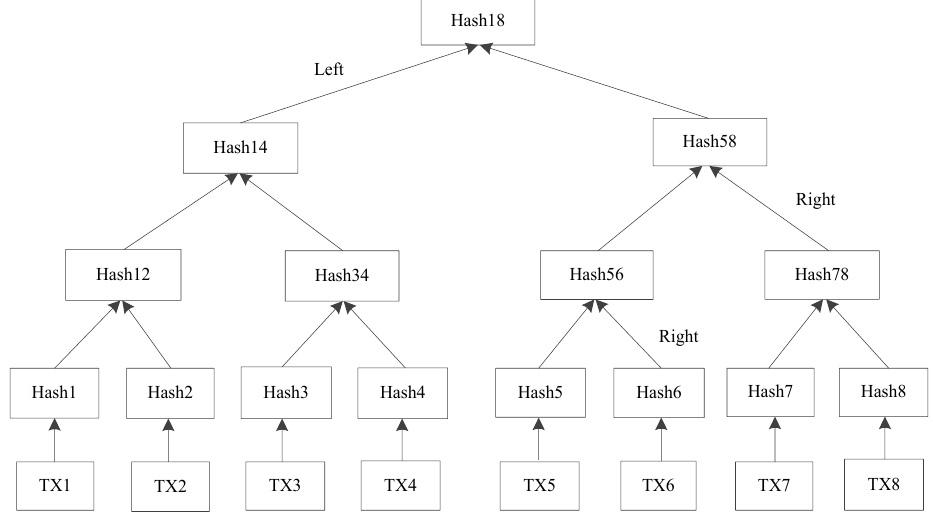
Figure 3. Verifying transaction existence.